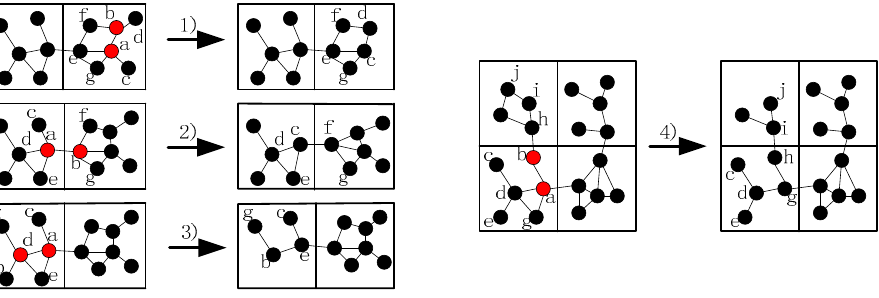
Figure 6. Different cases of multi-node failure.